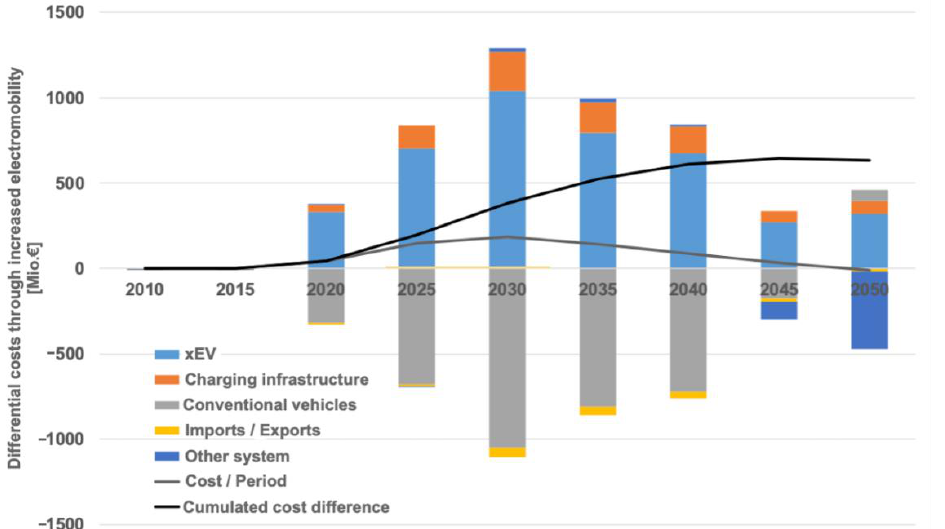
Figure 4. Discounted system cost difference due to increased electromobility (cumulated over 5-year periods), KLIMPLUS and KLIMPLUSLOW scenarios in comparison.